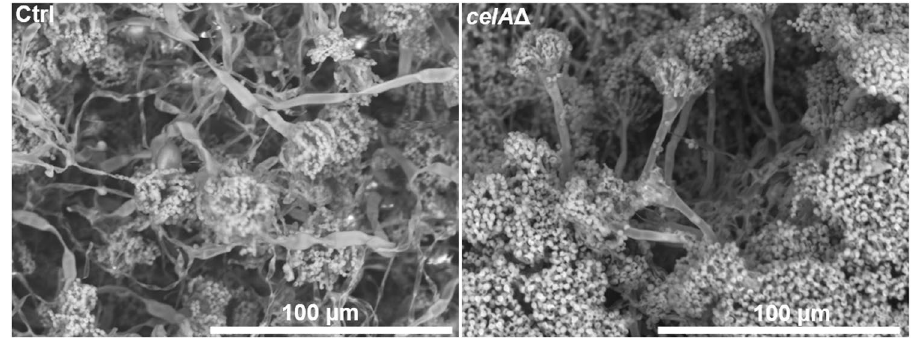
Figure 6. Scanning electron microscope pictures of the control (SAA.111) and celA Δ . The deleted strain forms more conidiophores and conidia than the control (the cultures are 4 days old).